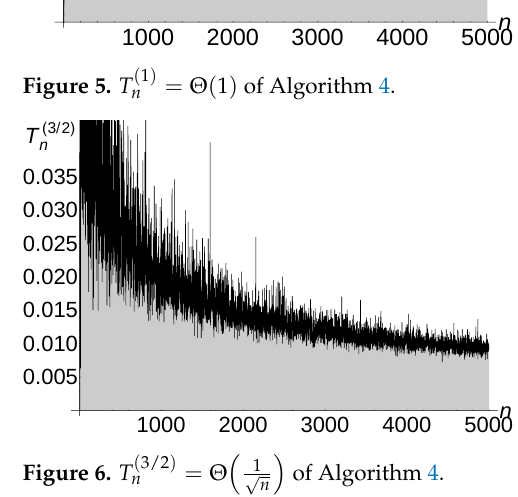
(cid:16) (cid:17) 1 of Algorithm n